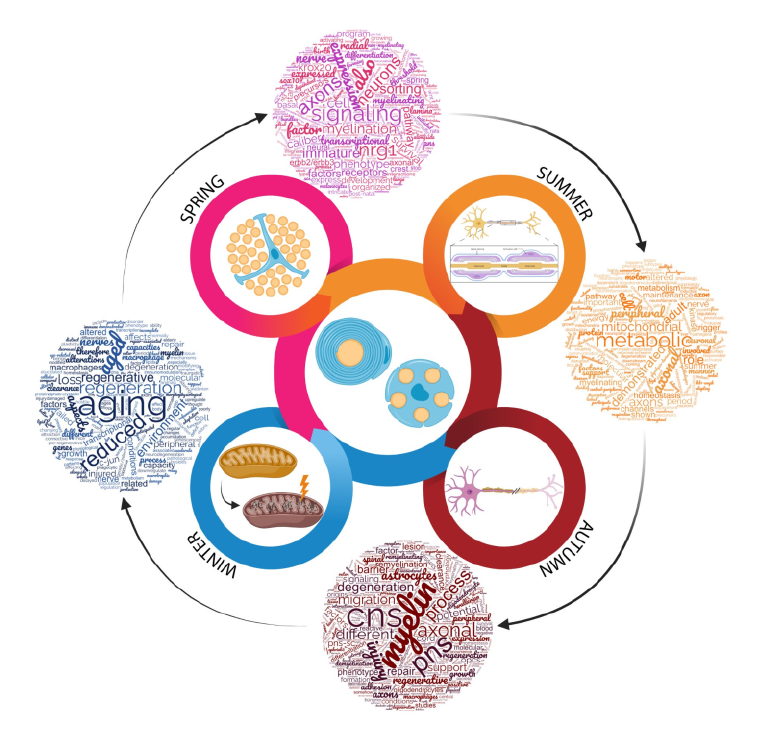
Figure 1. Dynamic art correlating the Schwann cell biological stages with the four